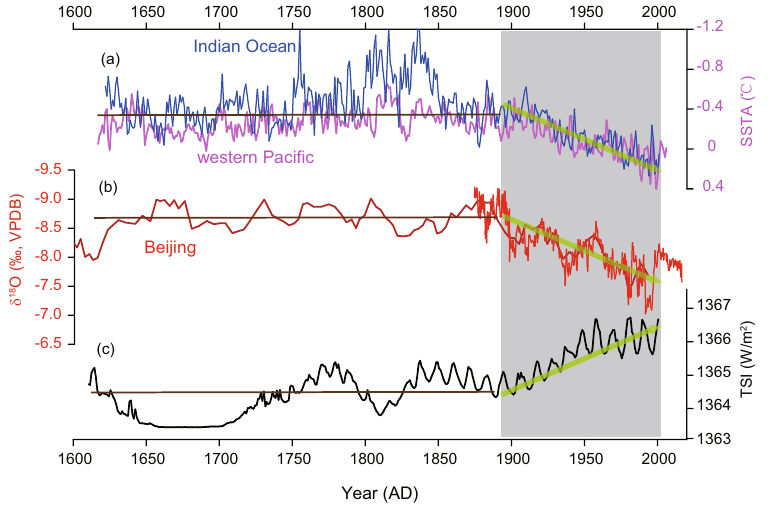
Figure 4. Comparison of climate records over the last 400 years. ( a ) Coral-based Sea Surface Temperature Anomaly (SSTA) in tropical Indian (blue) and western Pacific (pink) Oceans 55 . ( b ) The Shihua δ 18 O records (red, this study; dark red, S312) 43 . ( c ) Total solar irradiance (TSI, black) 56 . Arrows indicate the long-term variances and the dark gray rectangle shows the last century during which each record exhibits its distinct trend. Brown lines roughly depict the mean long-term variances before the